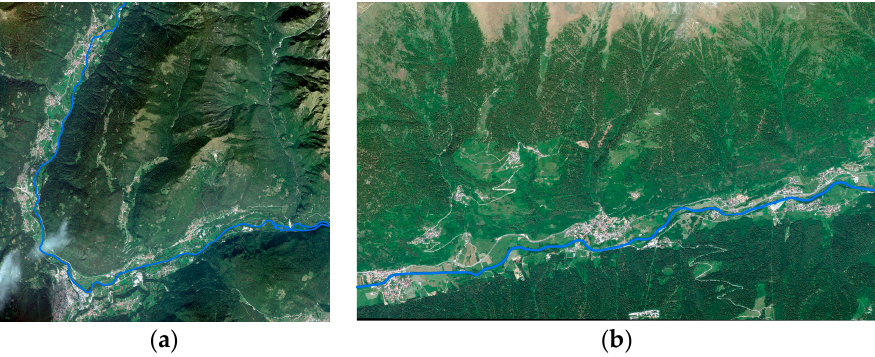
Figure 1. True color composites of ( a ) WV-3 image of Sarca River and ( b ) the GeoEye image of Noce River; the river channels are highlighted by blue lines.